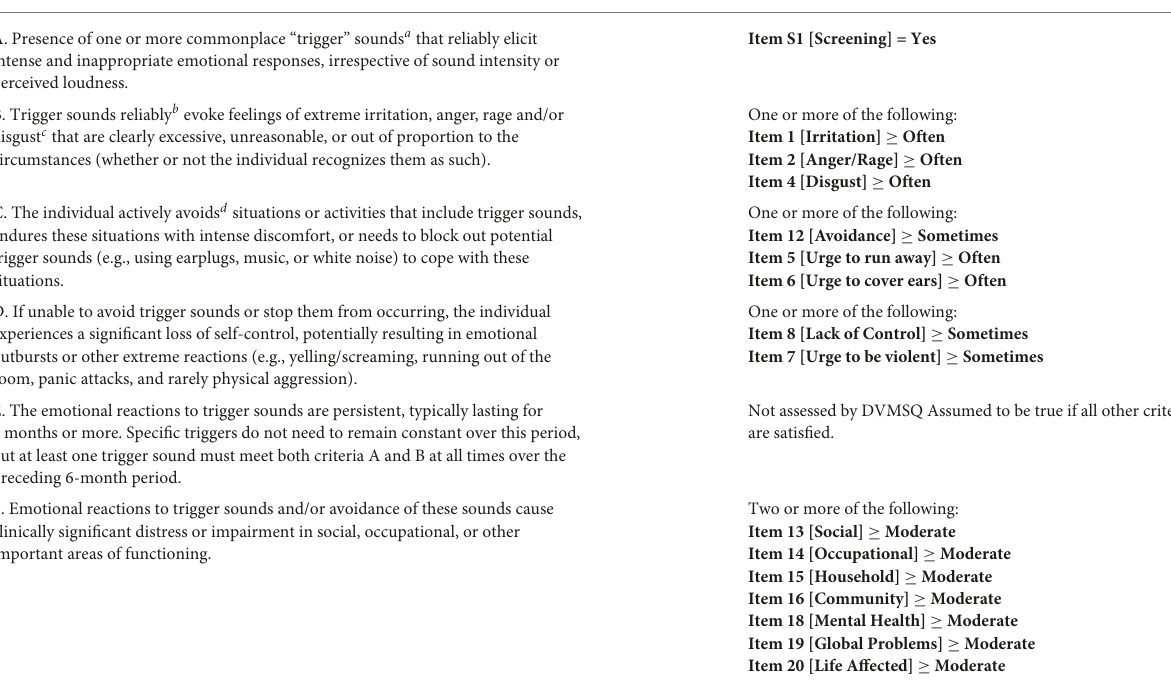
TABLE 2 Operational diagnostic criteria for misophonia and DVMSQ-based assessment.